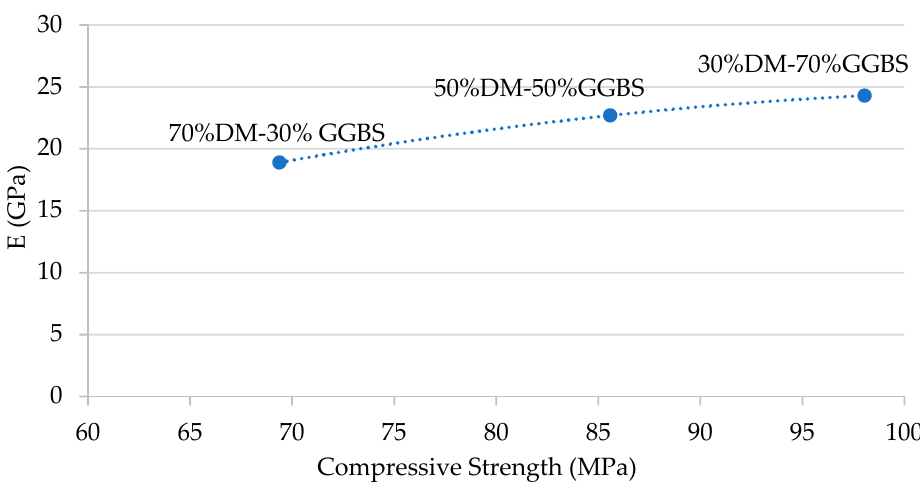
Figure 5. Modulus of Elasticity, E (GPa) vs. Compressive Strength (MPa) at 28 ‐ days maturity.